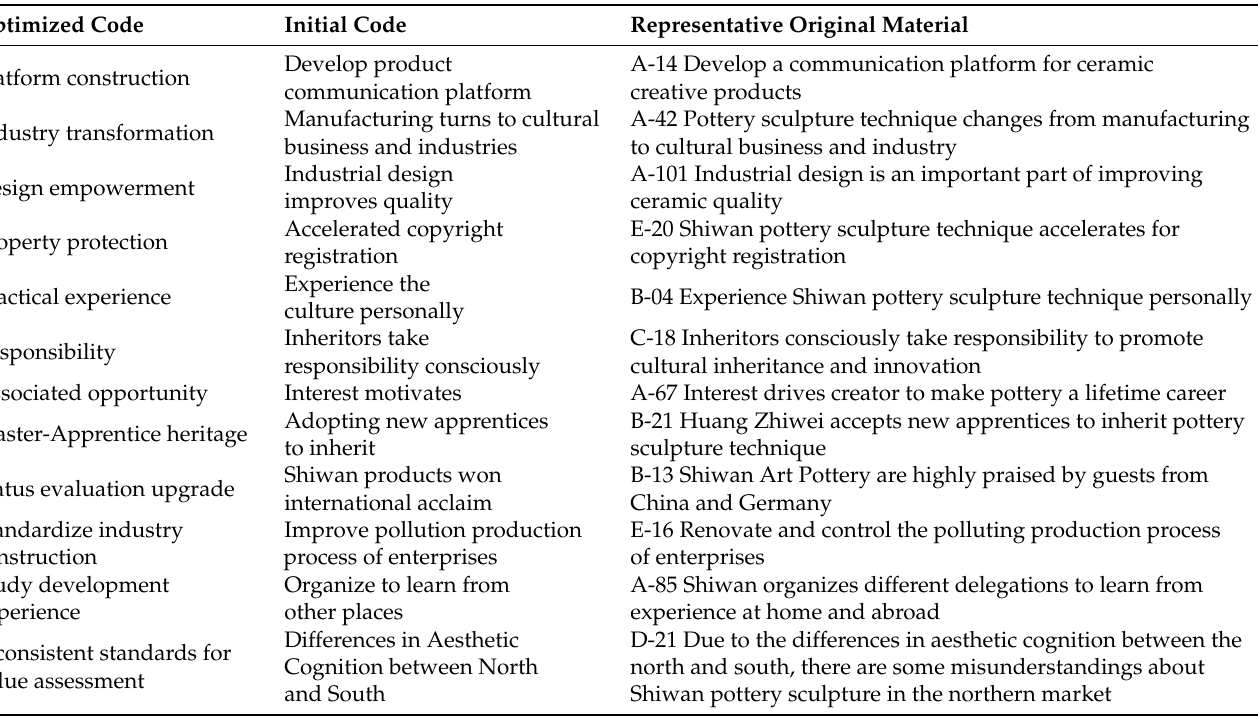
Table 2. Initial coding analysis results of Shiwan pottery sculpture technique’s effective text (some